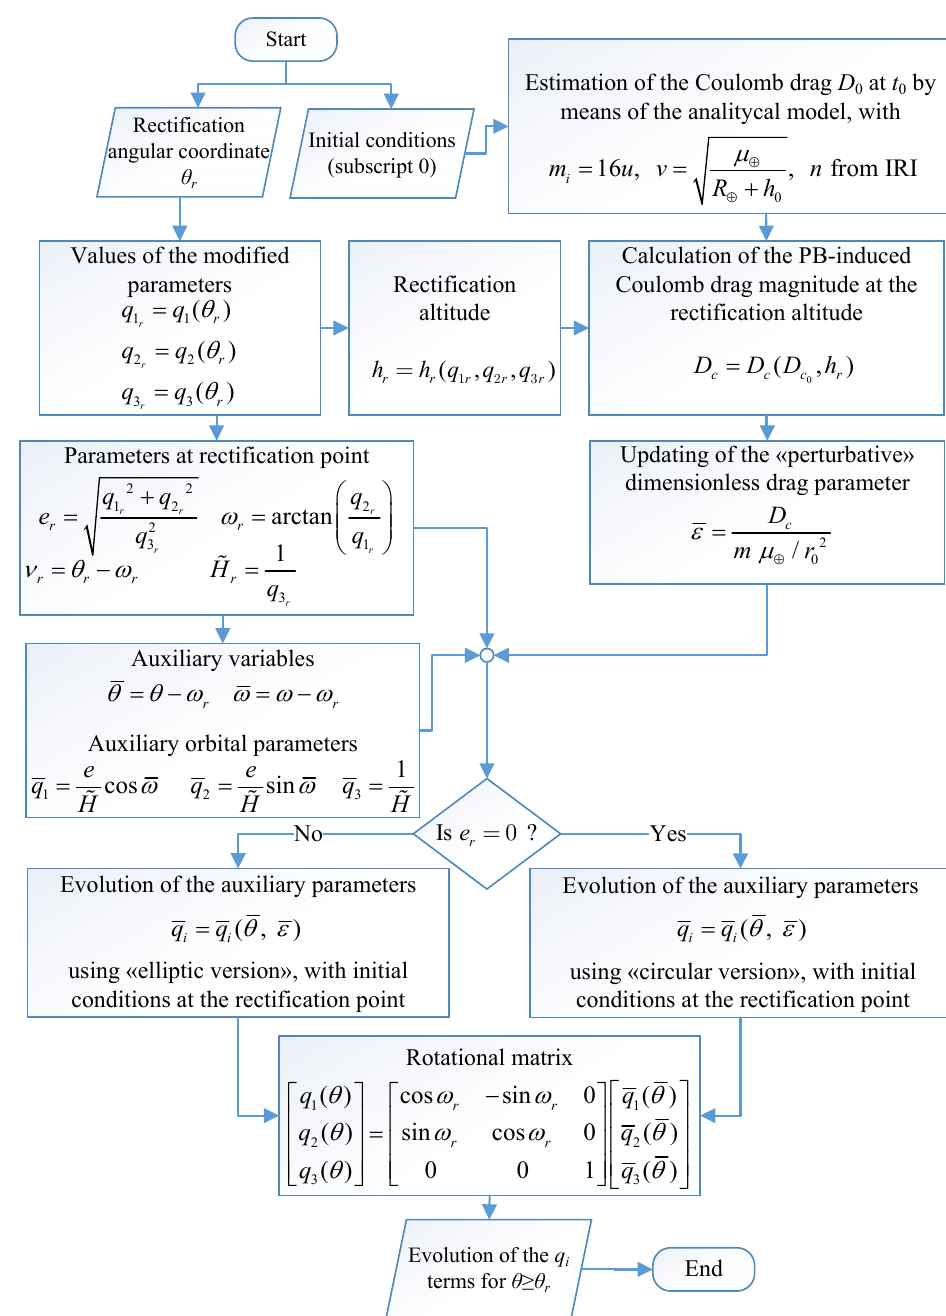
Figure 4. Block diagram of the rectification procedure